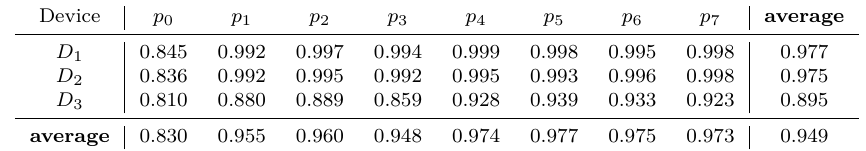
Table 4: Empirical probability p j to recover m [ j ] from a single trace using poly_A2A() . Device